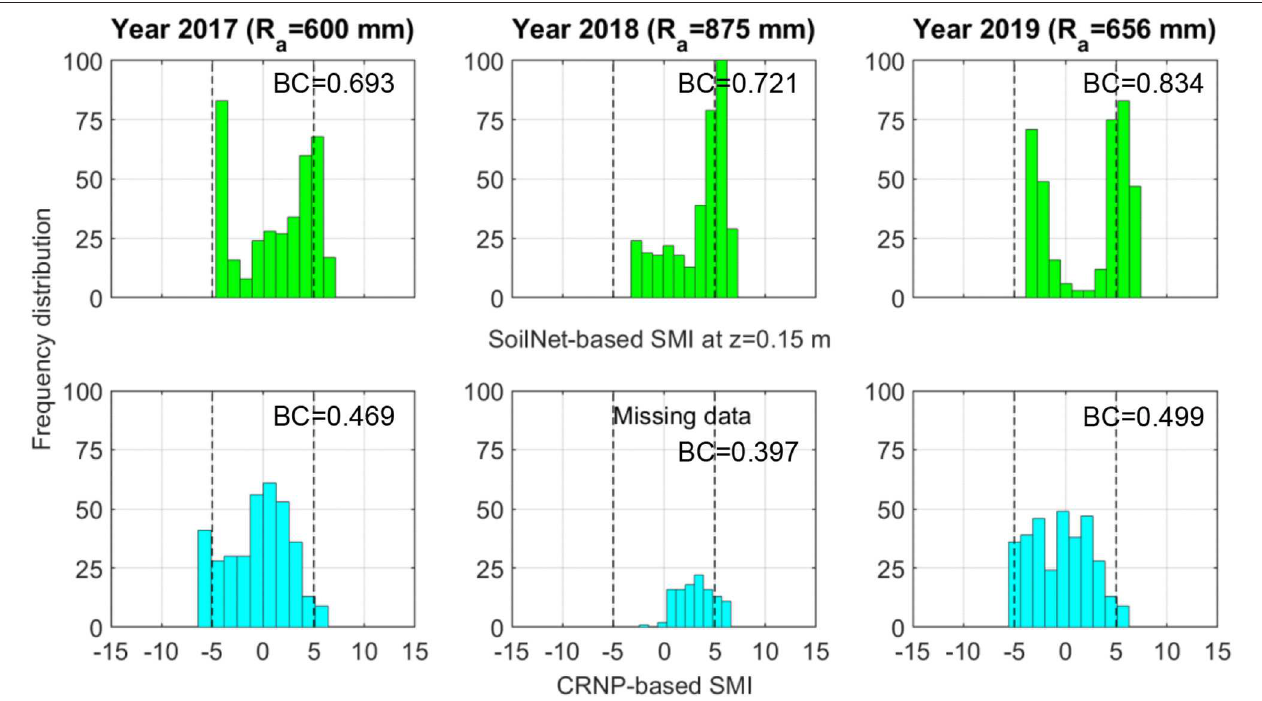
0.15m (green bars) and CRNP-based soil =